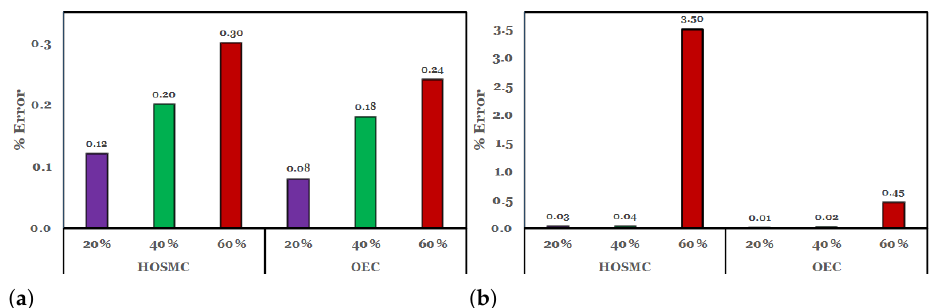
Figure 4. NEDC based analysis at 60 ◦ C.